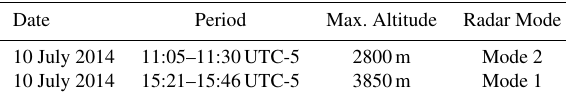
Table 3. SOUSY and DataHawk coordinated